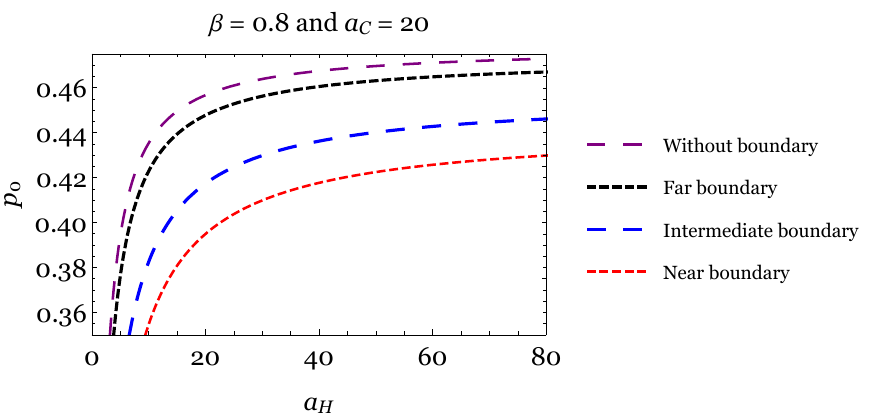
Figure 8. Behaviour of the critical probability p 0 with respect to a H for fixed values of β and a C